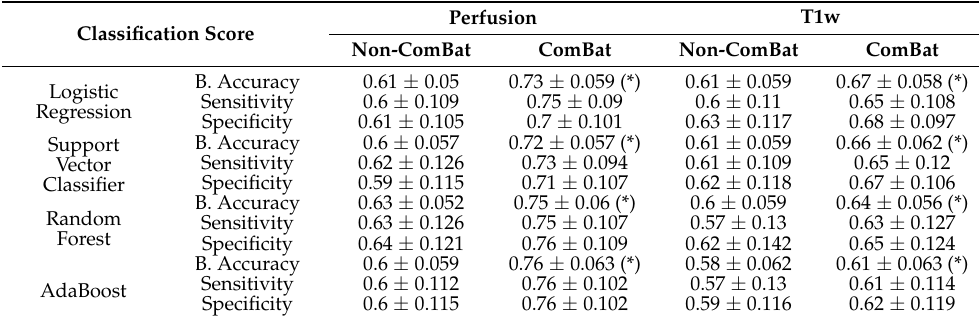
Table 3. Classification scores (balanced accuracy, sensitivity, and specificity) before and after harmo- nization for the two reference models (perfusion-based and T1w-based models).